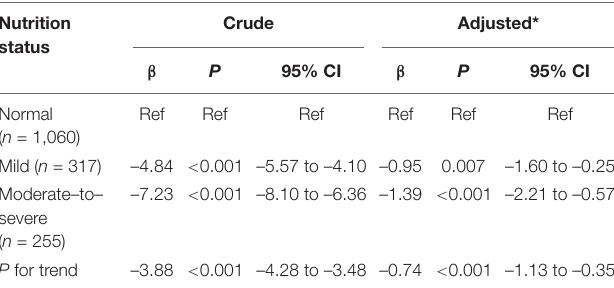
TABLE 2 | The association of malnutrition with cognitive function.